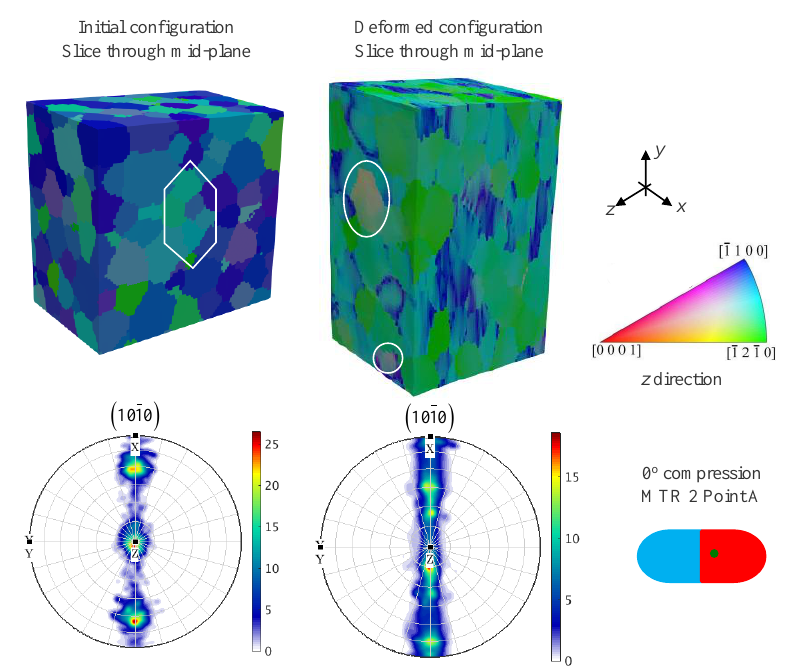
Figure 8. Microscale spatial inverse pole figure of MTR2 ( c -axis perpendicular to loading) before and after compression. The point corresponds to point A of region 2 in Figure 9, where an evenly distributed ( 10¯10 ) pole figure is observed. The hexagon represents the average orientation of the α p particles, and two α p particles with rotating c -axis are